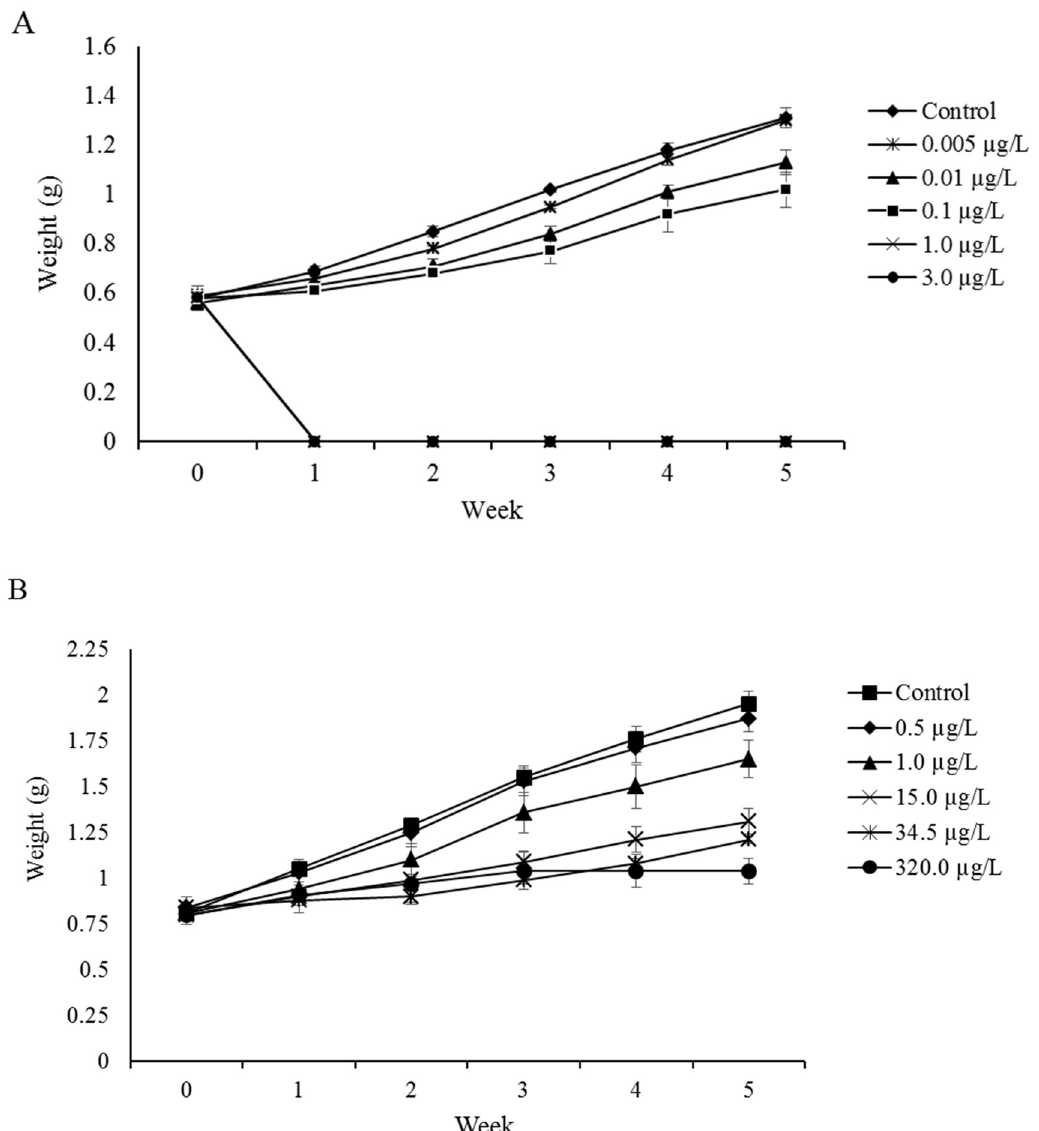
Fig 1. Wet weight of individual juvenile shrimp (g) during 5 weeks of the experiments. The vertical axis is the wet weight (g) of individual shrimp in each treatment, and the horizontal axis is the week from the beginning of experiment. Error bars indicate the standard errors (n = 18 in fipronil exp. and n = 15 in imidacloprid exp.). ( A ) Fipronil experiment, ( B ) Imidacloprid